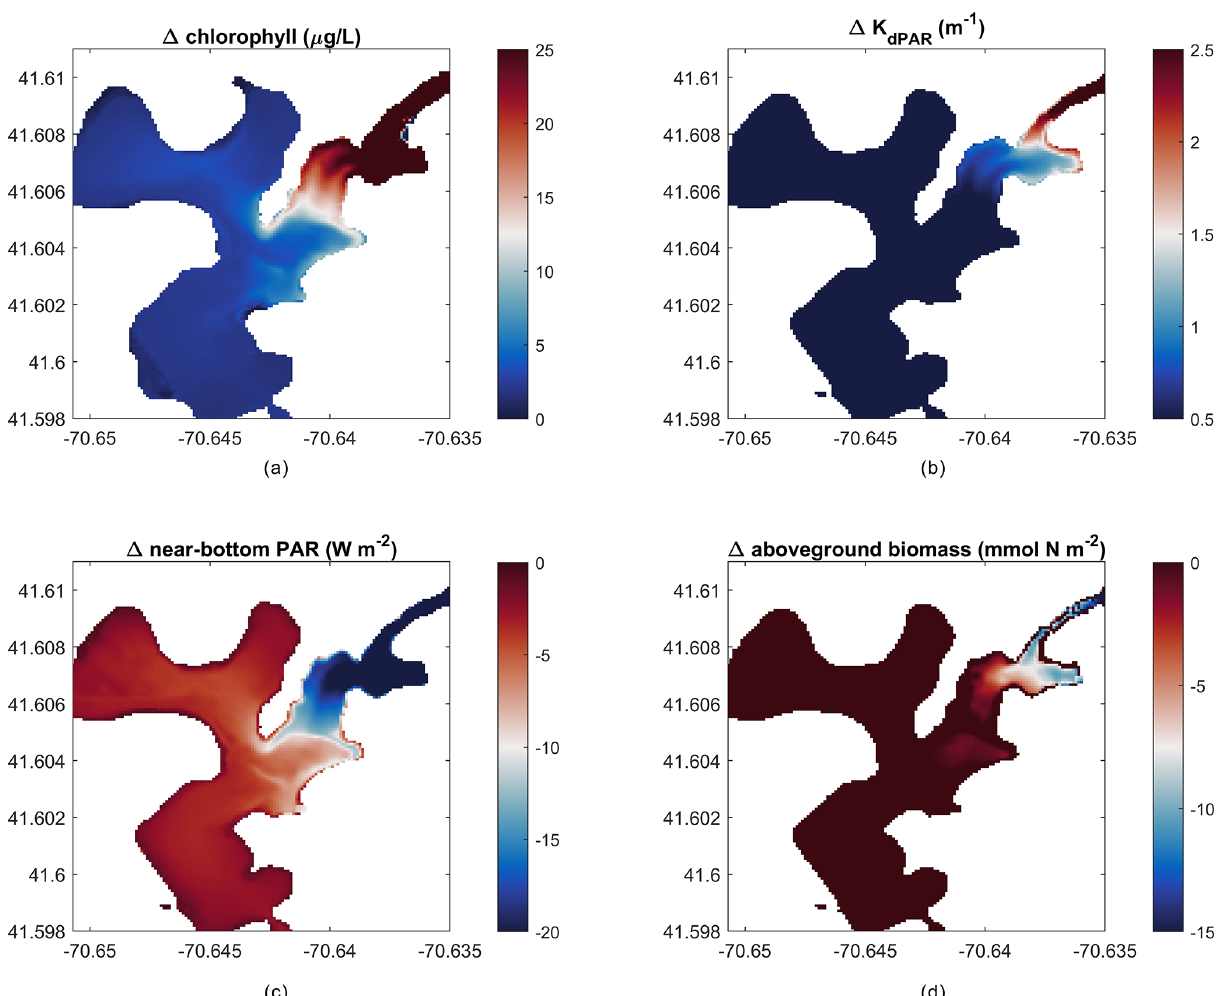
Figure 10. Change in outcomes between impacted and non-impacted scenarios (nitrate loading scenario – no loading scenario). Difference in mean over 22d of (a) depth-averaged chlorophyll, (b) light attenuation, (c) near-bottom PAR, and (d) peak aboveground biomass on day 14 of the